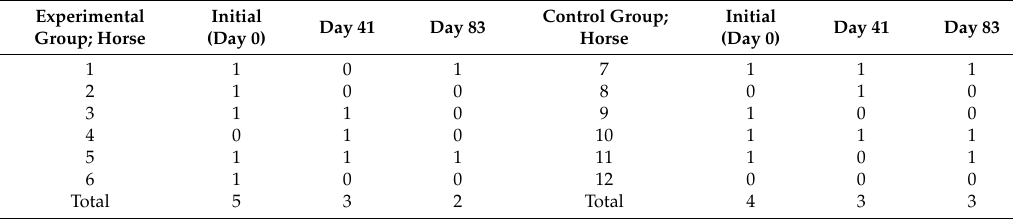
Table 2. Numbers of horses with endoscopy examination findings in the two groups. Experimental Group; Horse